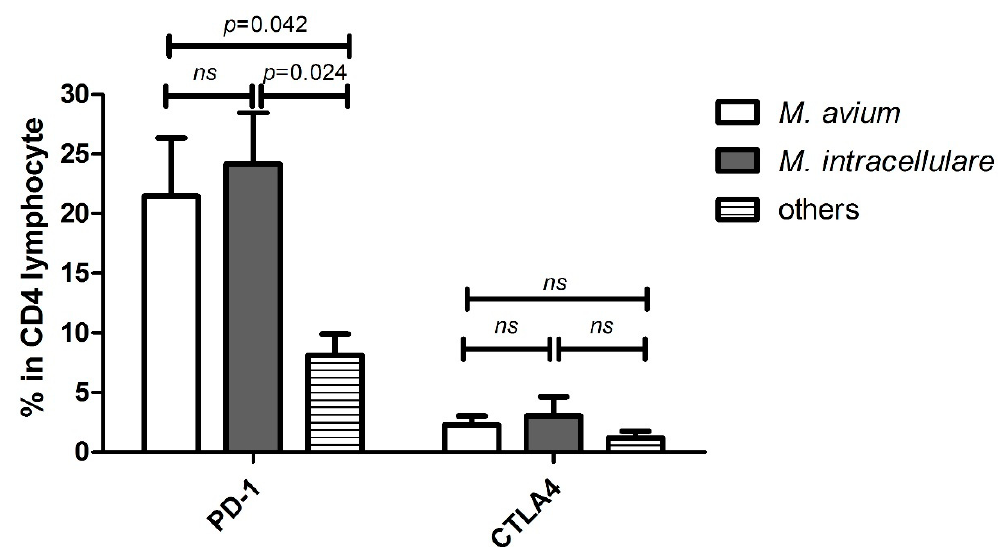
Figure 2. The proportion of programmed death-1 (PD-1) and cytotoxic T-lymphocyte antigen-4 (CTLA-4) on CD4 + lymphocytes in Mycobacterium avium complex-lung disease according to di ff erent causative subspecies. The data in the bar charts are mean values, and error bars are standard errors. The data were compared using the Mann Whitney U test. M ., mycobacterium ; ns, not statistically significant ( p > 0.05)